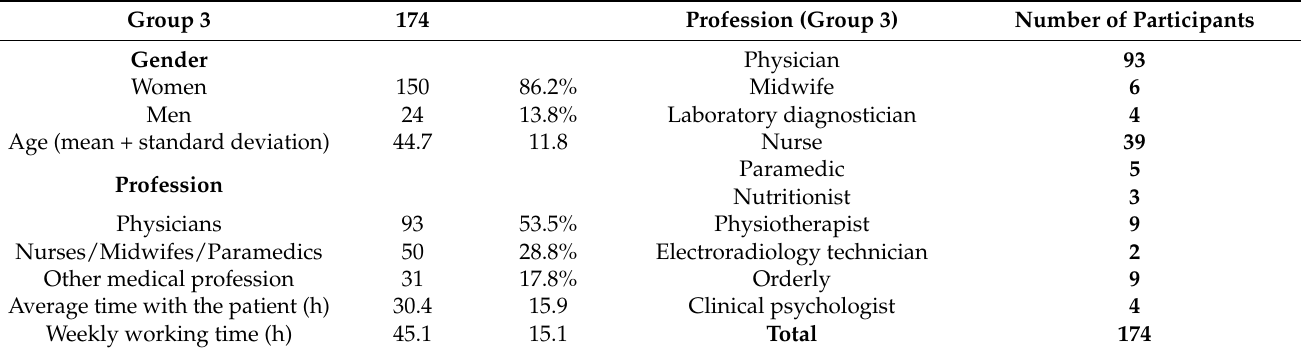
Table 6. Characteristics of group 3 with profession